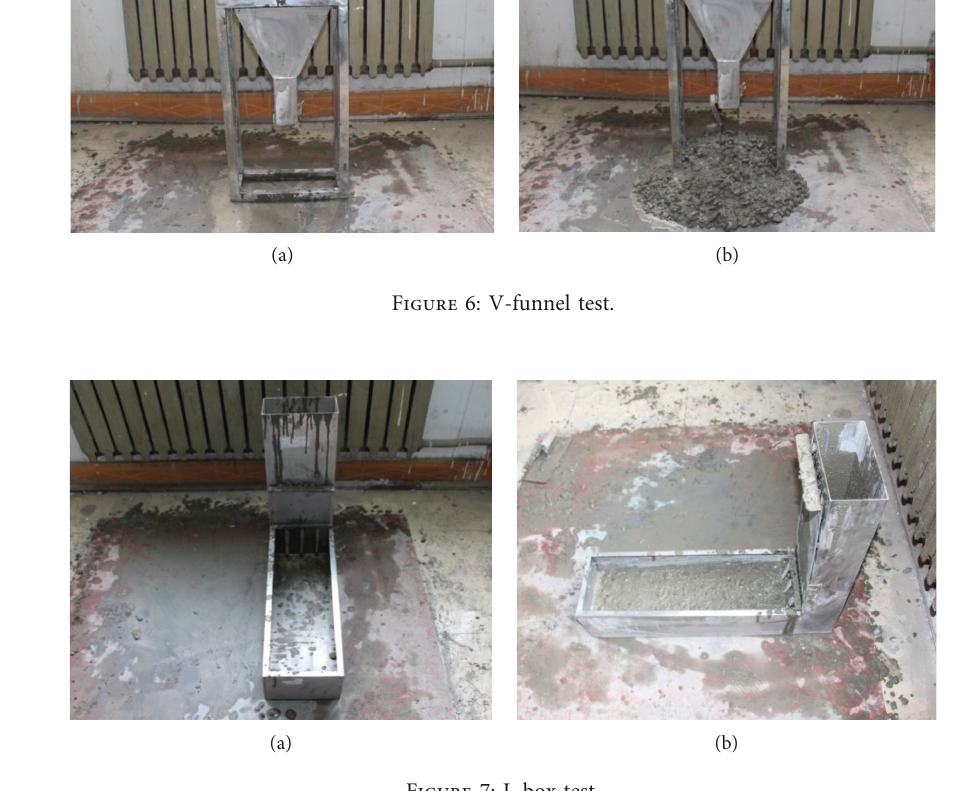
Figure 7: L-box test.